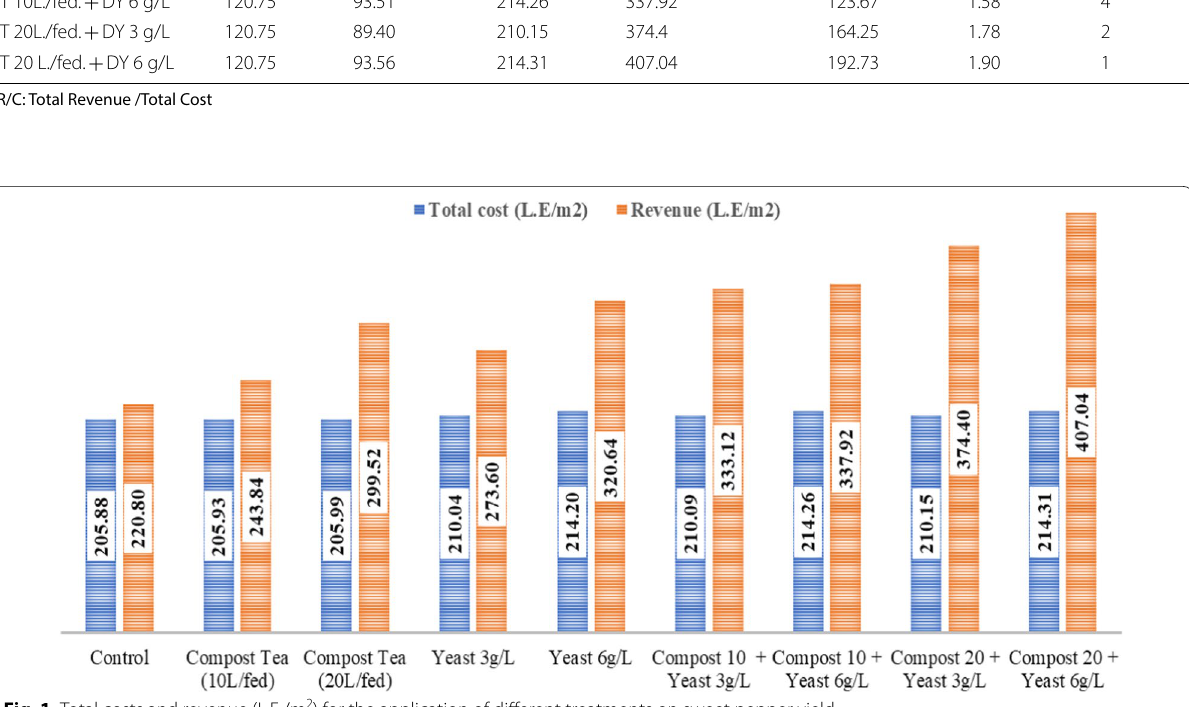
Fig. 1 Total costs and revenue (L.E./m 2 ) for the application of different treatments on sweet pepper